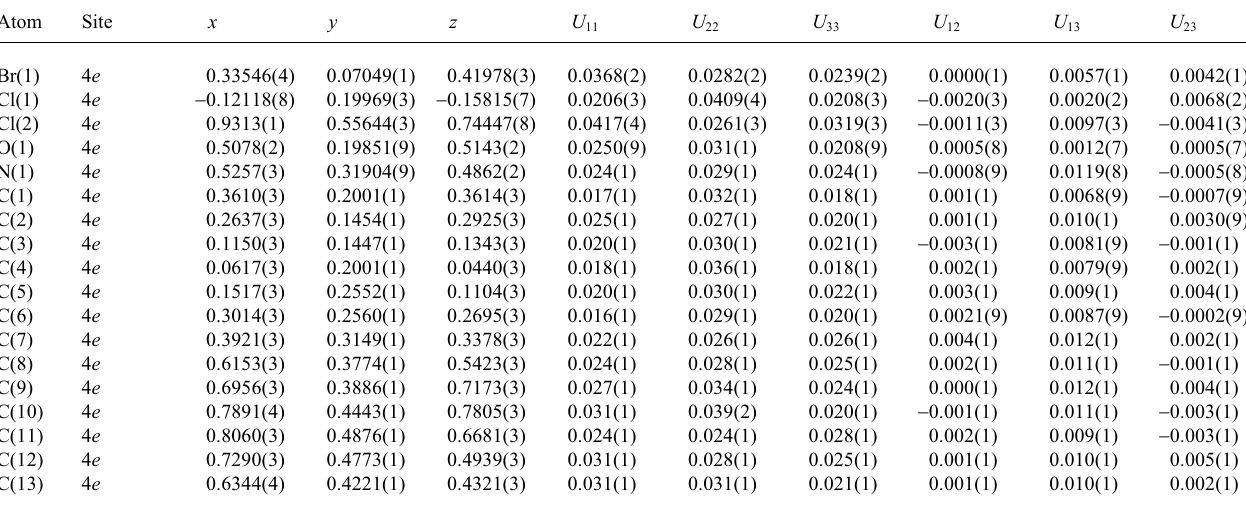
Table 3. Atomic coordinates and displacement parameters (in Å 2